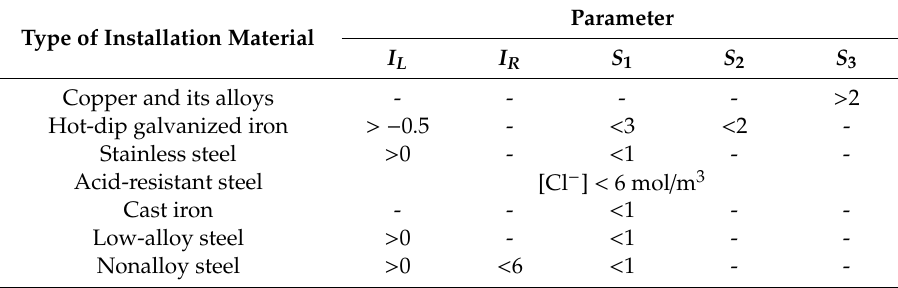
Table 2. Values of indicators at which corrosion of individual installation materials will not occur (based on [22–26,35,36]).